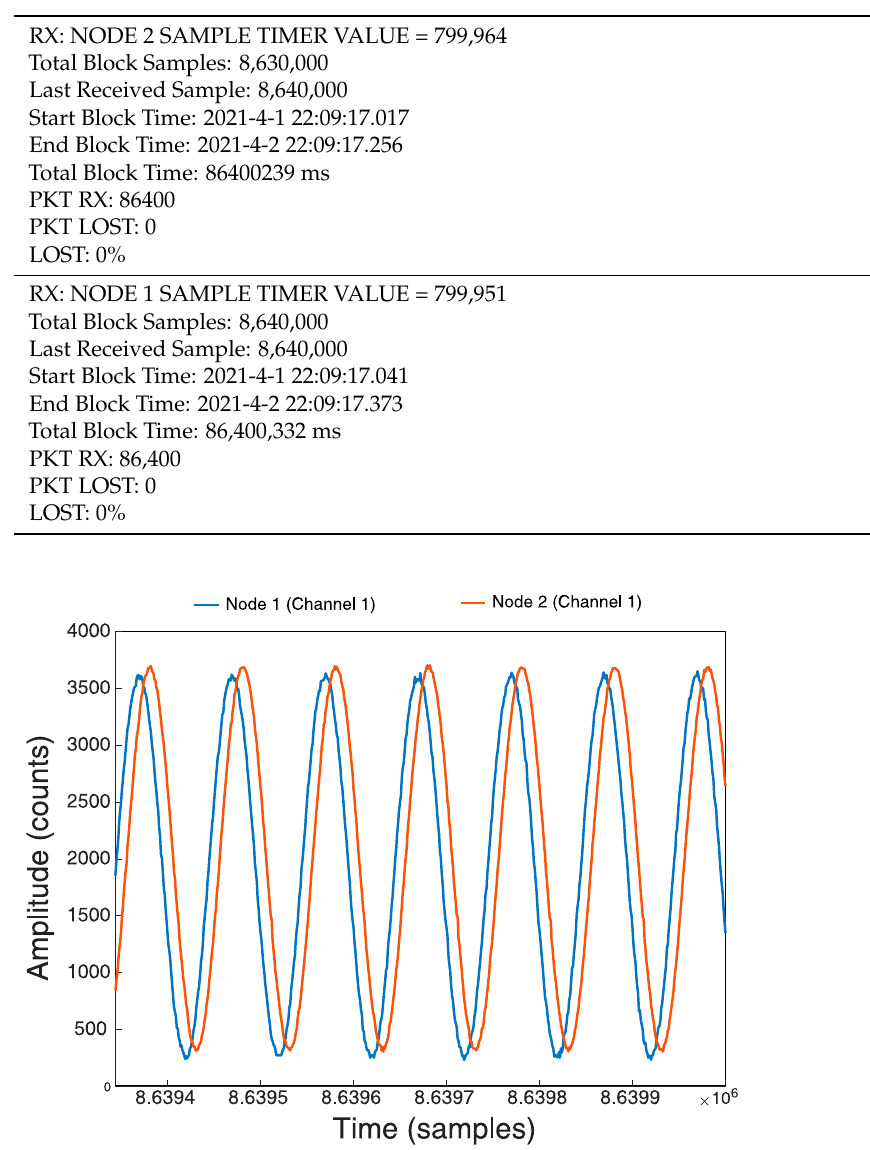
Table 5. Results of 24 h with Stop-and-Go = 8 h.